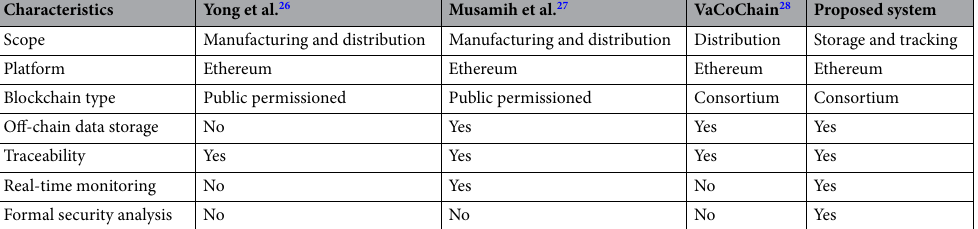
Table 3. Comparison with existing blockchain-based